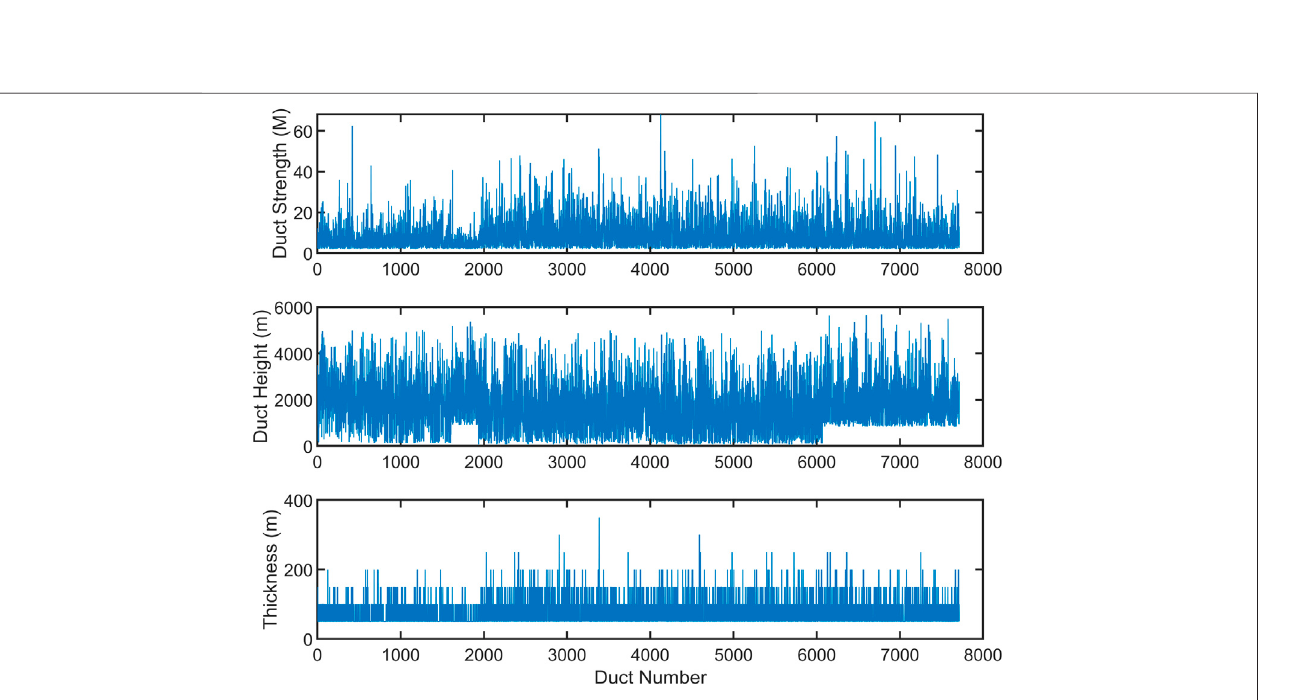
Frontiers in Environmental Science |